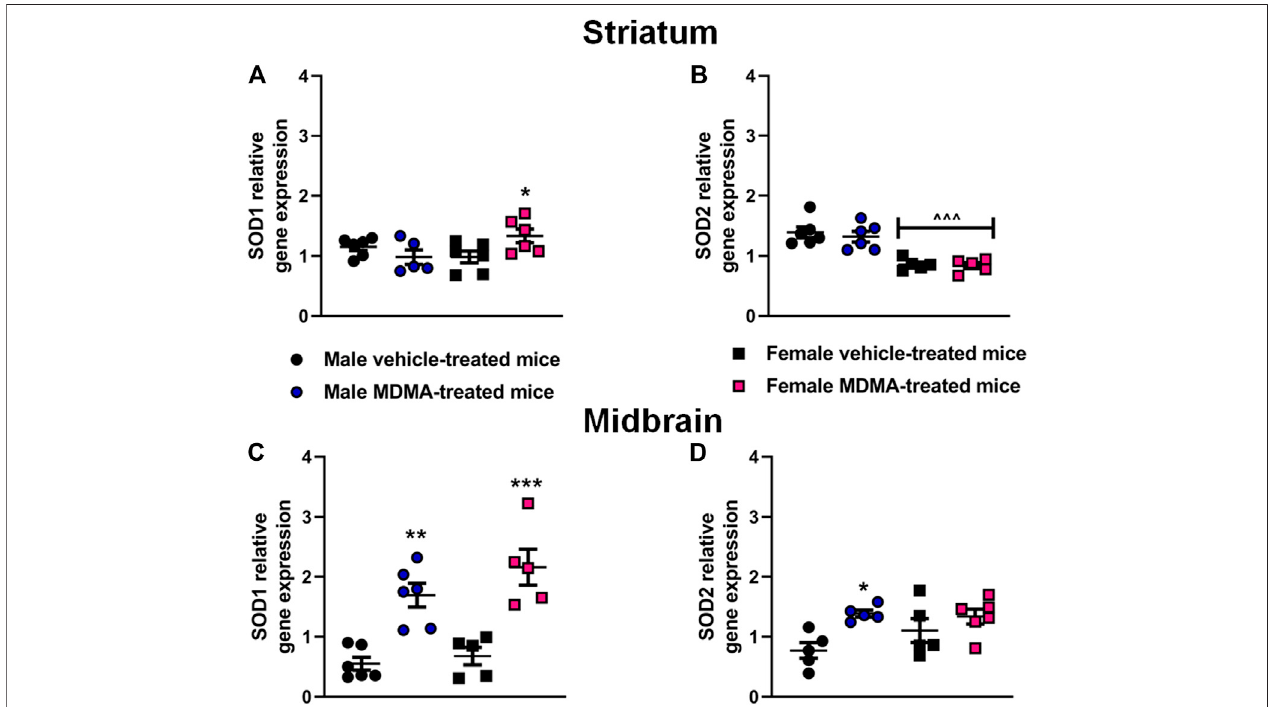
FIGURE 4 | Effects of treatment with MDMA on superoxide dismutase 1 (SOD1) and superoxide dismutase 2 (SOD2) gene expression in the striatum (A,B) and midbrain (C,D) .AdultmaleandfemalemiceweretreatedwitheitherMDMA(4 × 20 mg/kg,i.p.2 hapart)orvehicle(salinesolution,i.p.).N (cid:2) 5 – 6micepergroup.Values are reported as mean ± S.E.M. * p < 0.05, ** p < 0.01 and *** p < 0.001, compared with the respective groups of vehicle-treated mice; ∧∧∧ p < 0.001 compared with the respective groups of male mice, by Newman-Keuls post-hoc